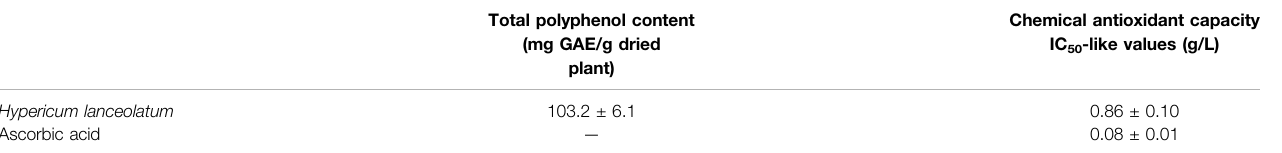
TABLE2| Totalpolyphenolcontentandchemicalantioxidant capacityof Hypericumlanceolatum aqueous extract(resultsareexpressedasmeans±SEMof3independent experiments). Note that the DPPH chemical test was done to check for potential antioxidant compounds but is of no pharmacological relevance.